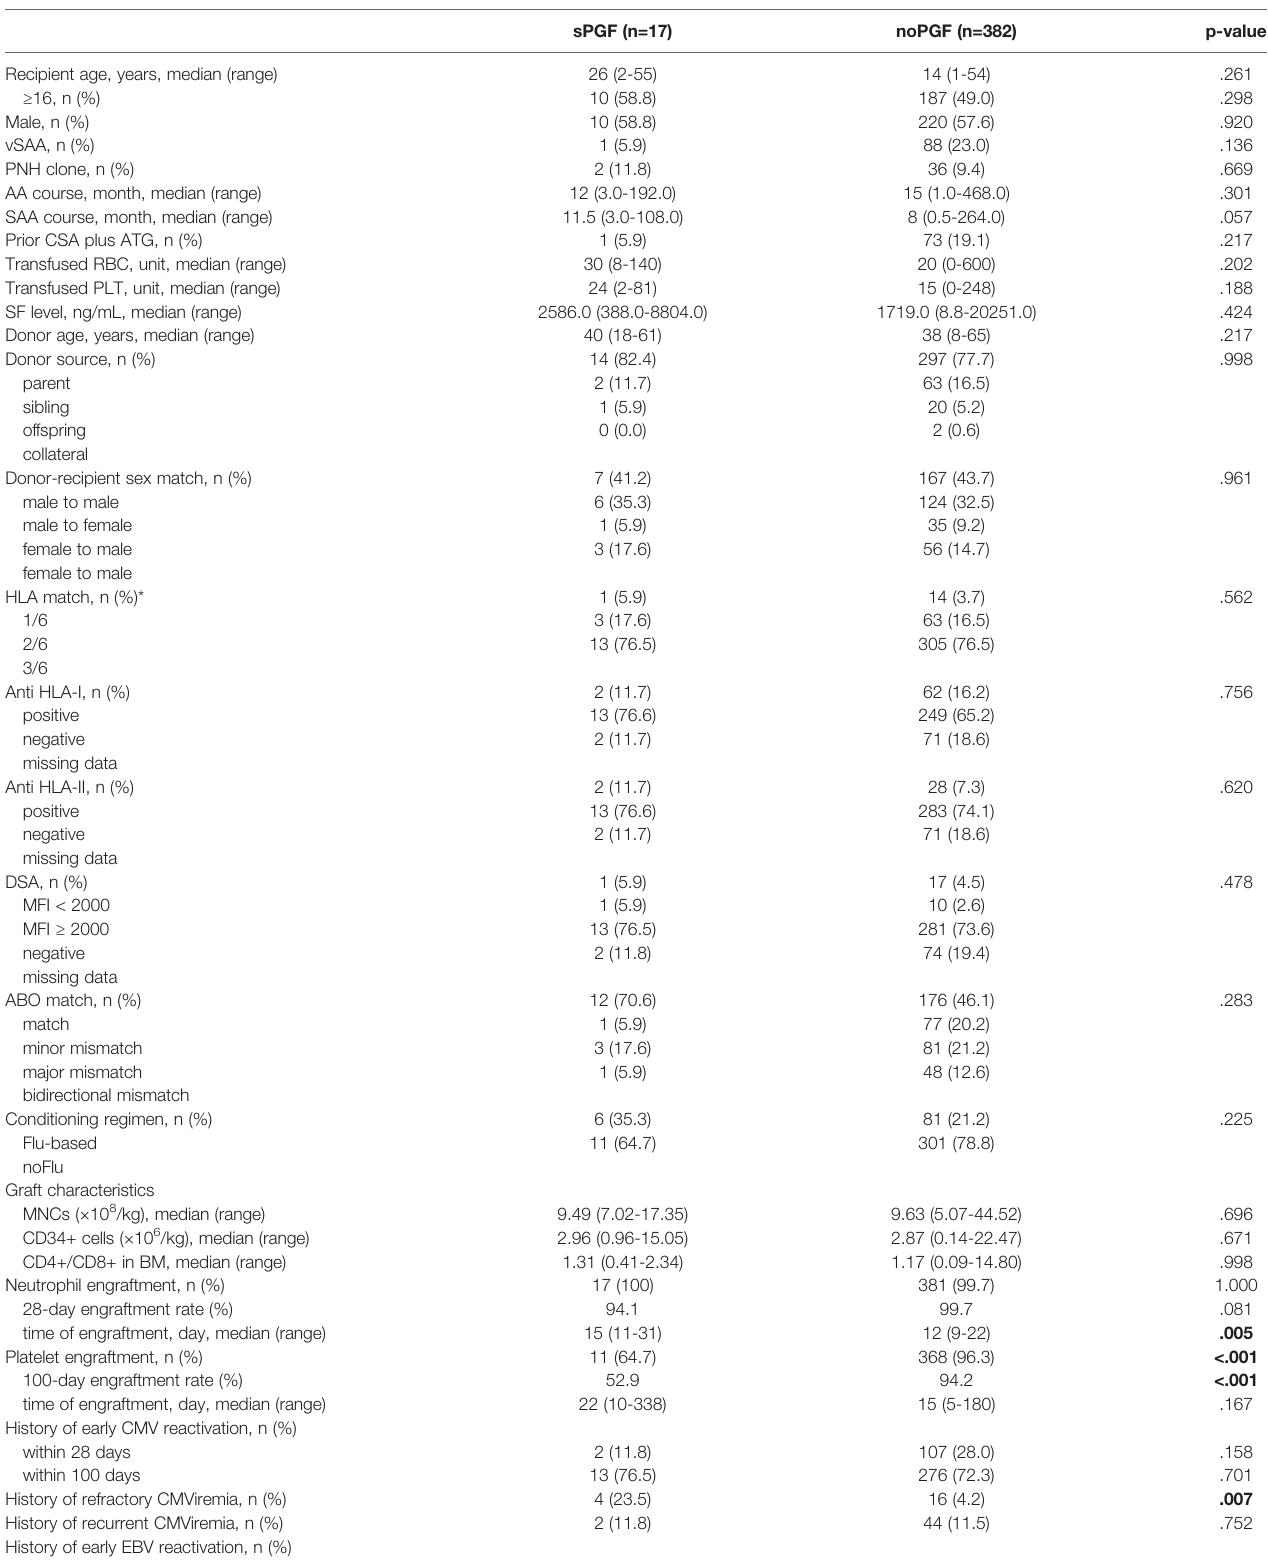
TABLE 1 | Characteristics of sPGF and noPGF groups and post-transplantation